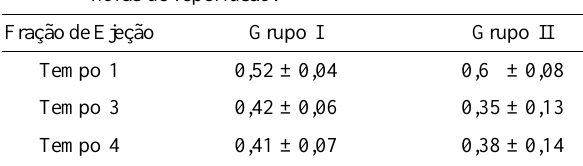
Tabela 6. Valores médios com seus respectivos desvios-padrão da fração de ejeção nos animais dos grupos I e II, submetidos em CEC, a duas horas de isquemia e três horas de reperfusão.